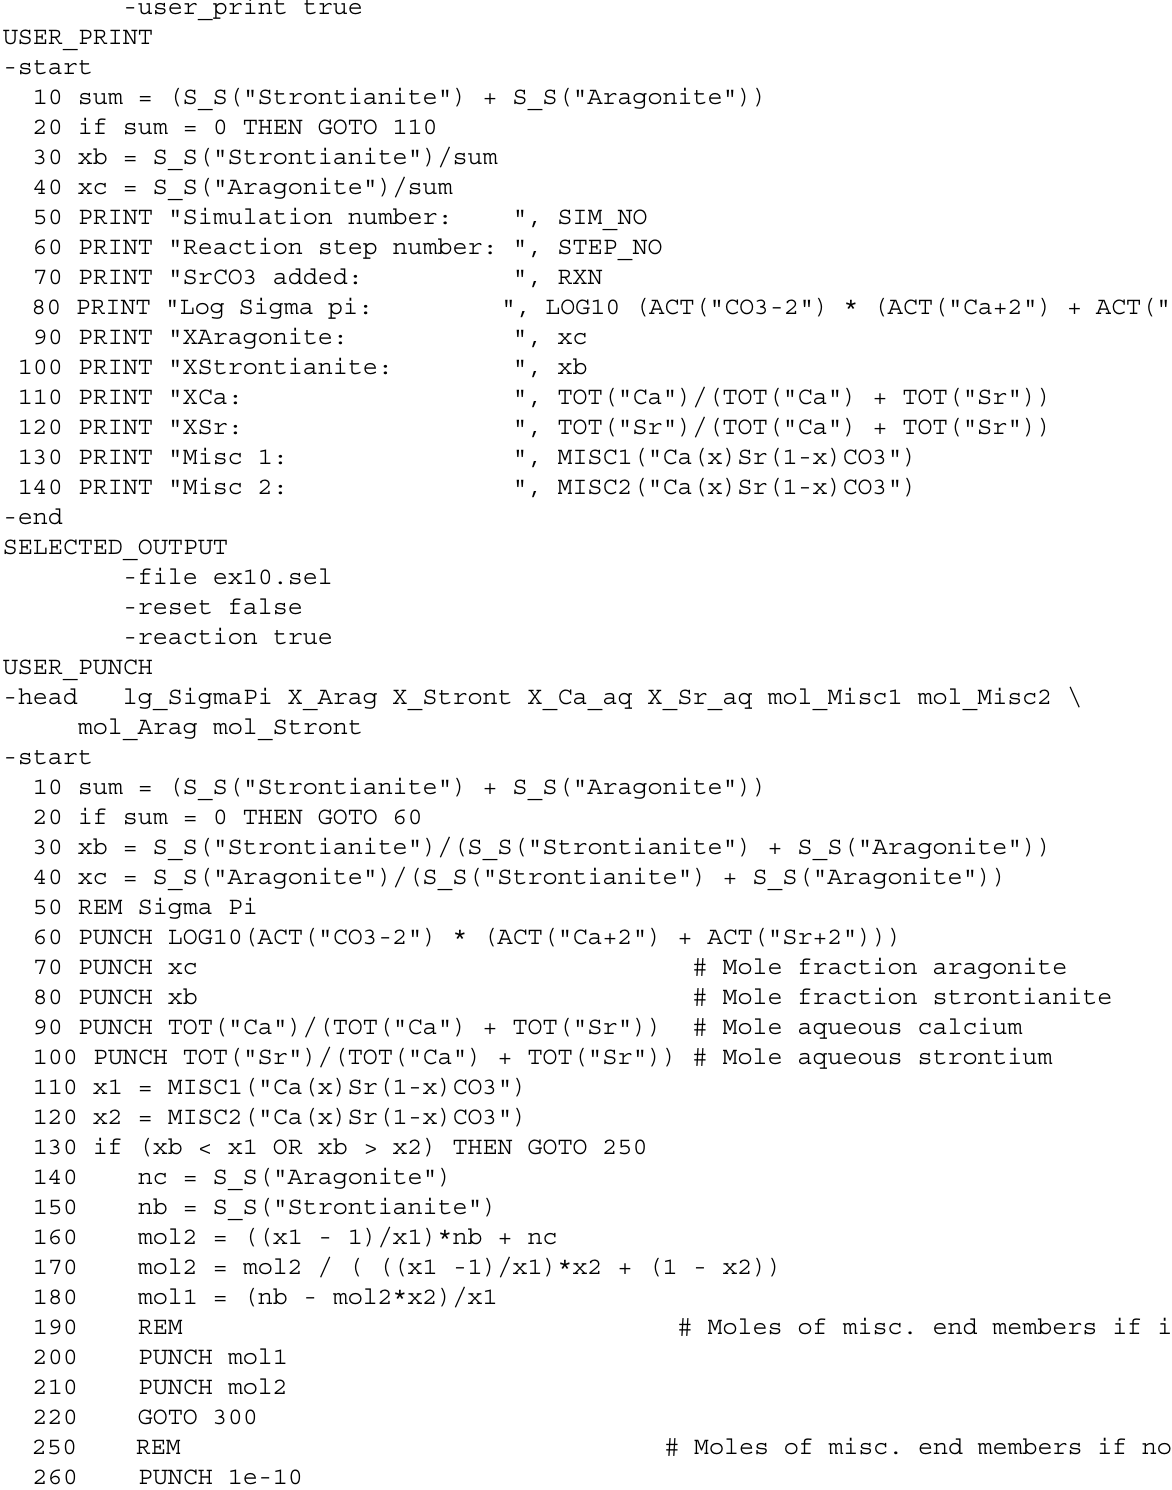
Table 29. Input file for example